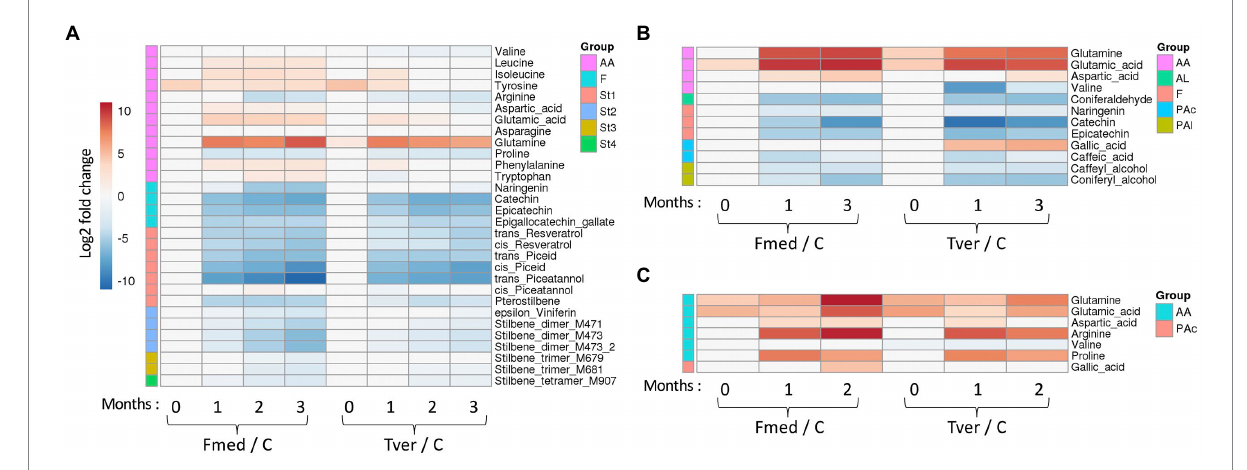
FIGURE 6 Targeted metabolomic analysis of the wood degradation process. Log2 of significant metabolite fold changes for indicated pairwise comparisons are given by shades of red or blue colors according to the scale bar for (A) grapevine, (B) beech and (C) spruce cultures. Data represent the mean values of three biological replicates for each condition and time point. Statistical analyses were performed by Tukey’s honest significant difference method followed by false discovery rate (FDR) correction, with FDR < 0.05. For FDR ≥ 0.05, Log2 fold changes were set to 0. AA: amino acids; AL: aldehydes; F: flavonoid; PAc: phenolic acids; PAl: phenolic alcohols; St1 to St4: Stilbene monomers, dimers, trimers and tetramers; MXXX: m/z in positive mode. C: